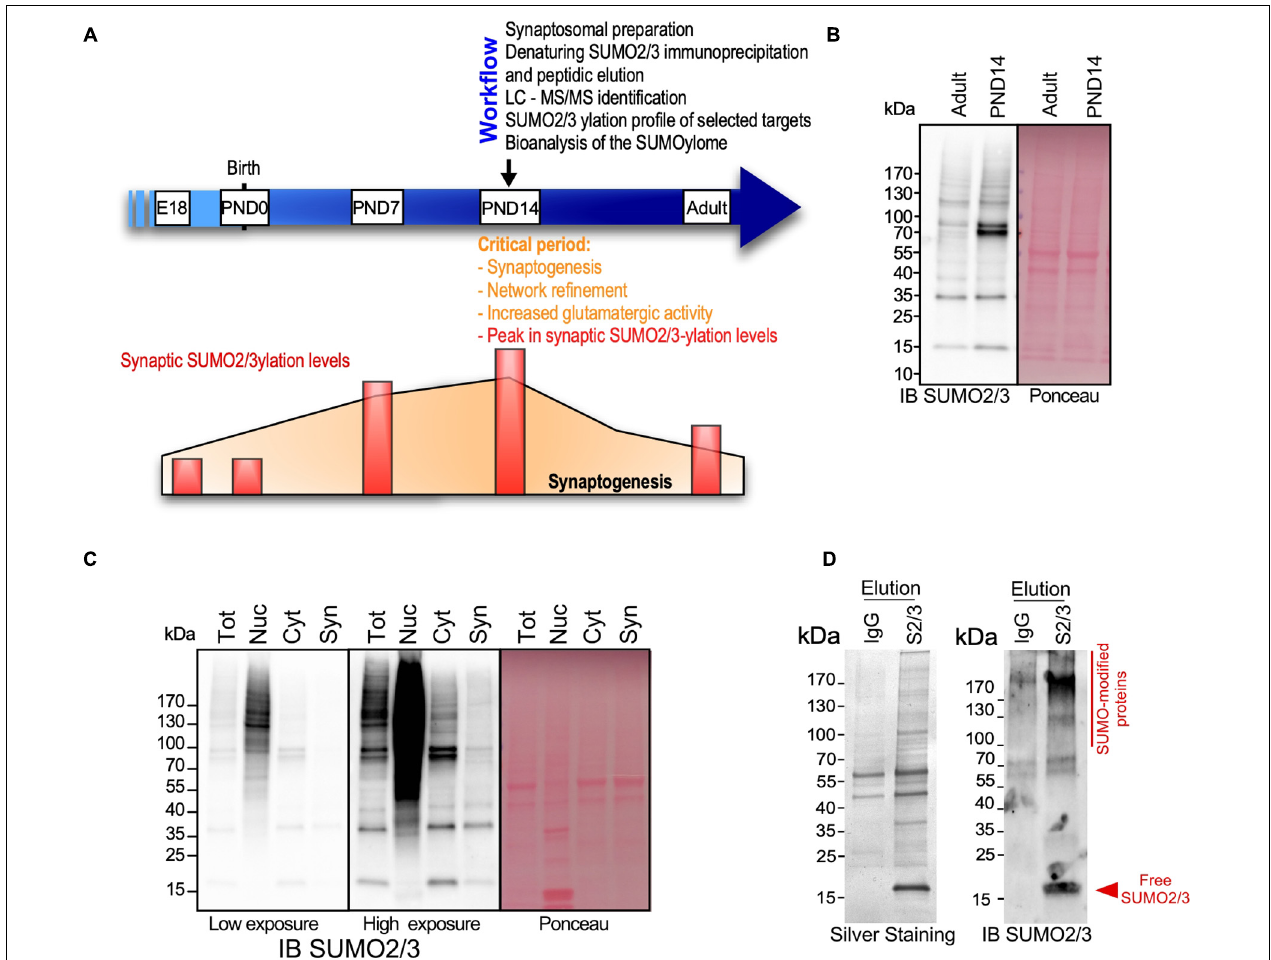
FIGURE 1 | Identification of the synaptic SUMO2/3-ylome. (A) Workflow to identify the synaptic SUMO2/3-ylome. PND14 rat brains, presenting intense synaptogenesis, neurotransmission and high levels of SUMO2/3-ylation, were subjected to biochemical subcellular fractionation to prepare synaptosomes. Denaturing immunoprecipitations were performed on the synaptosomal fractions using specific SUMO2/3 antibodies and peptidic elution. Isolated proteins were then identified by LC-MS/MS. The SUMO2/3-ylation profile of several selected targets was analyzed by biochemical approaches and the biological significance of the synaptic SUMO2/3-ylome was brought out by bio-informatics analysis. (B) Immunoblotting of SUMO2/3-ylation levels in PND14 and adult brain for SUMO2/3 (left panel). Ponceau-S staining was used to detect total proteins (right panel). (C) SUMO2/3-ylation levels detected by immunoblotting on 20 µ g of proteins from indicated subcellular fractions. After low-speed centrifugation of the total brain lysate (Tot), the supernatant corresponding to the cytoplasmic fraction (Cyt) was loaded on sucrose percoll gradients to isolate the synaptosomal fraction (Syn) (Loriol et al., 2014) and the nuclear fraction (Nuc) in the pellet was purified on sucrose cushions (Boisvert et al., 2010). (D) Ten percent of the SUMO2/3 12F3 (S2/3) or control IgG immunoprecipitated proteins were subjected to silver staining (left panel) or SUMO2/3 immunoblotting (right